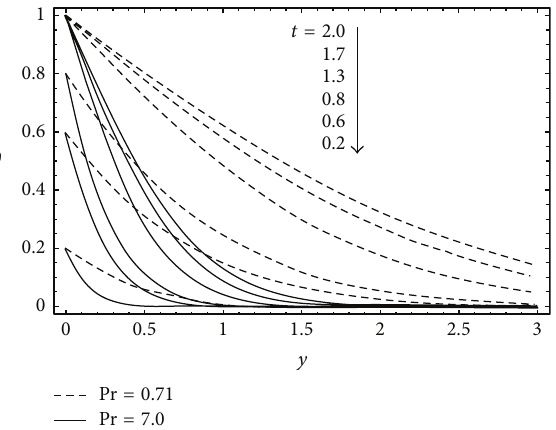
Figure 4: Velocity profiles for different values of 𝑡 with 𝜂 = 0.8 and Pr = 7.0 .